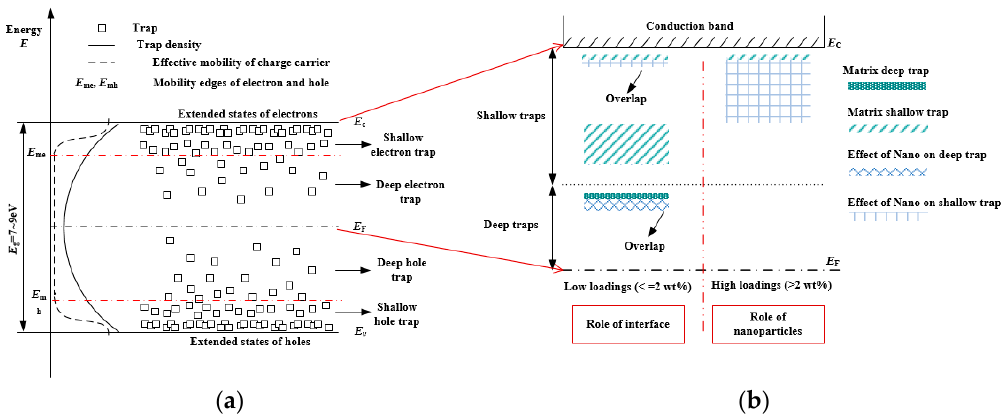
Figure 10. Trap variation due to interface region and nanoparticles in LDPE/TiO 2 nanocomposites based on the energy band diagram. (a) Energy band structure; (b) effects of interface and nanoparticles on traps.